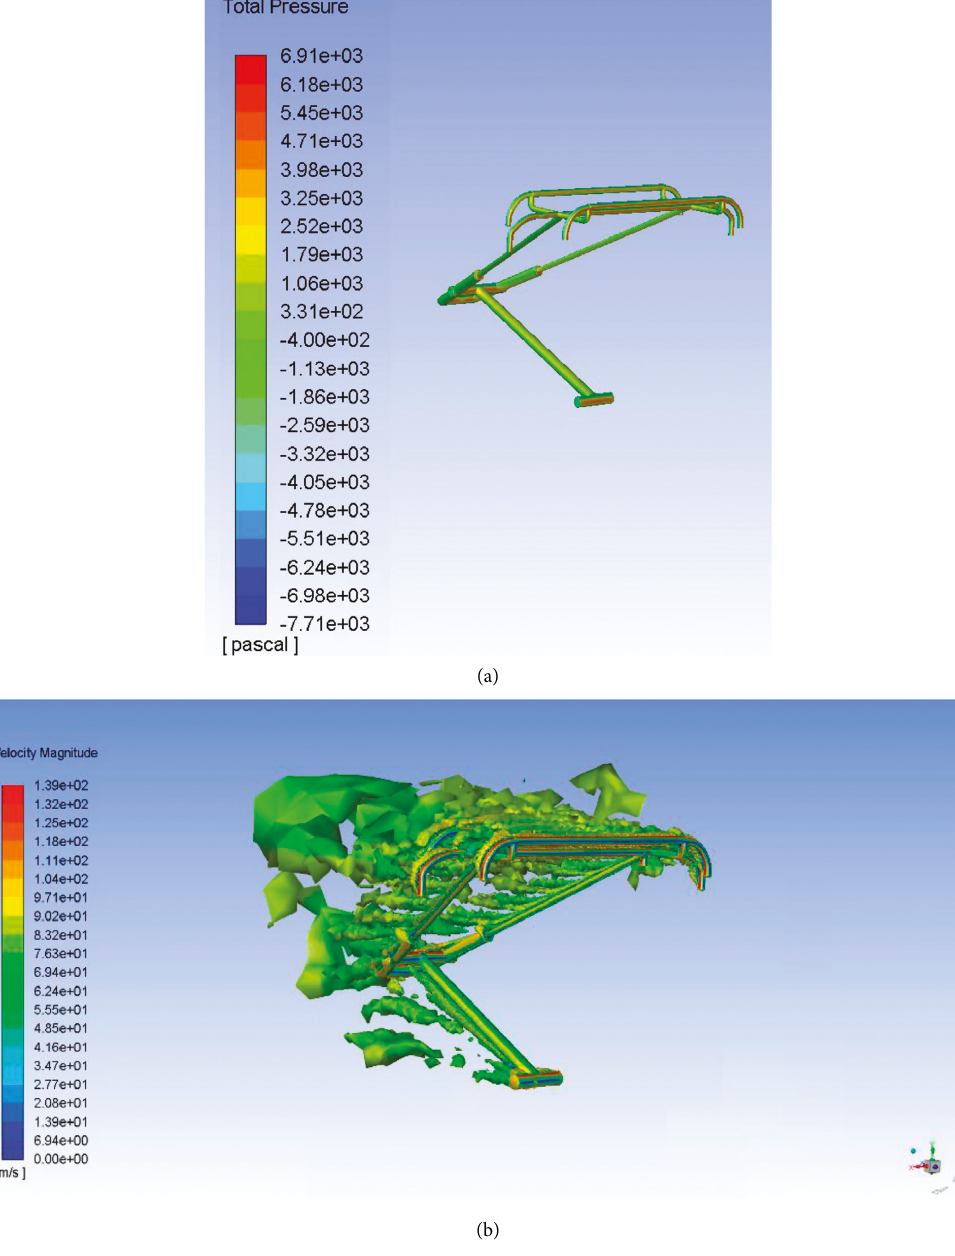
Figure 11: Simulation of a full pantograph model. (a) Total pressure contour; (b) instantaneous vortex